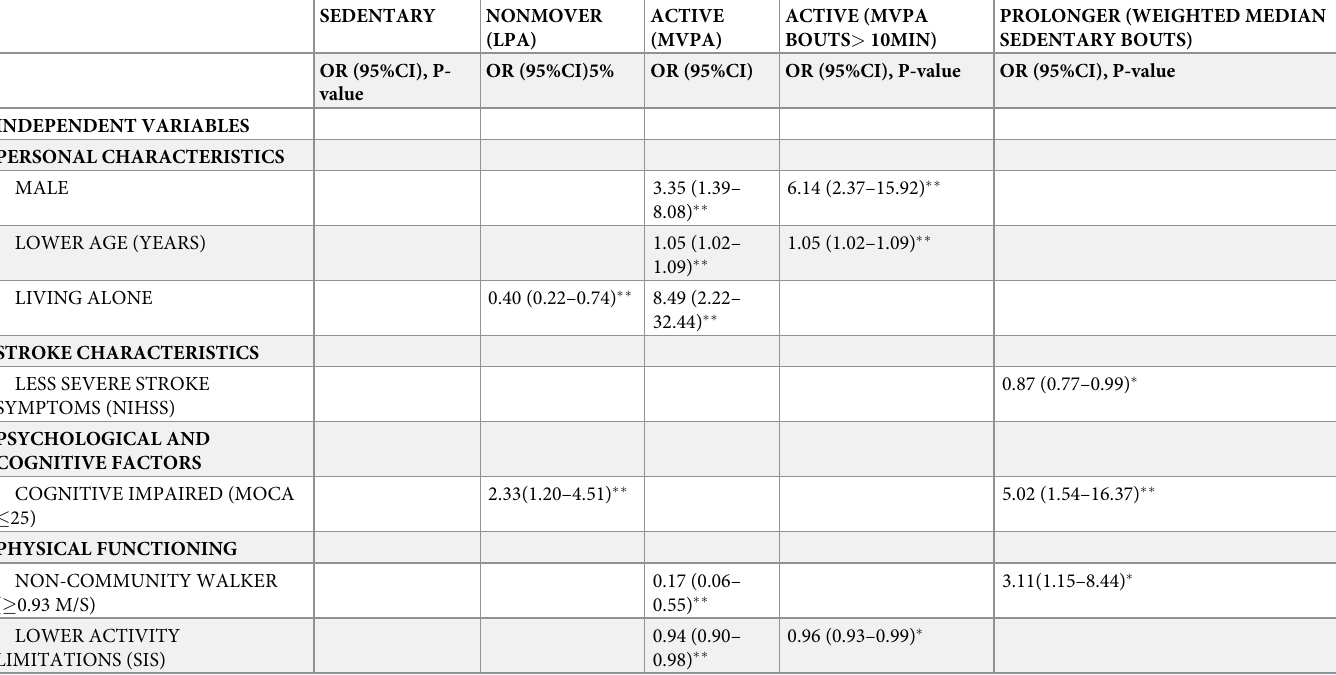
Table 5. Associated characteristics per movement behavior pattern using multiple logistic